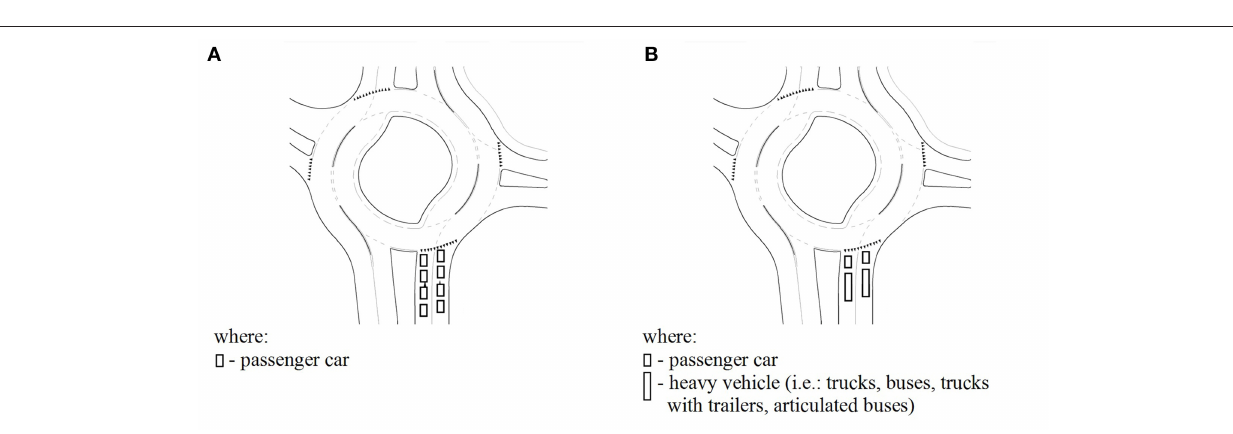
FIGURE 3 | The situations taken into account during measurements of the follow-up times between the vehicles entering the circular roadway from turbo roundabout entry lanes. (A) Only passenger cars. (B) Passenger cars and heavy vehicles (i.e., trucks, buses, truck with trailers, articulated